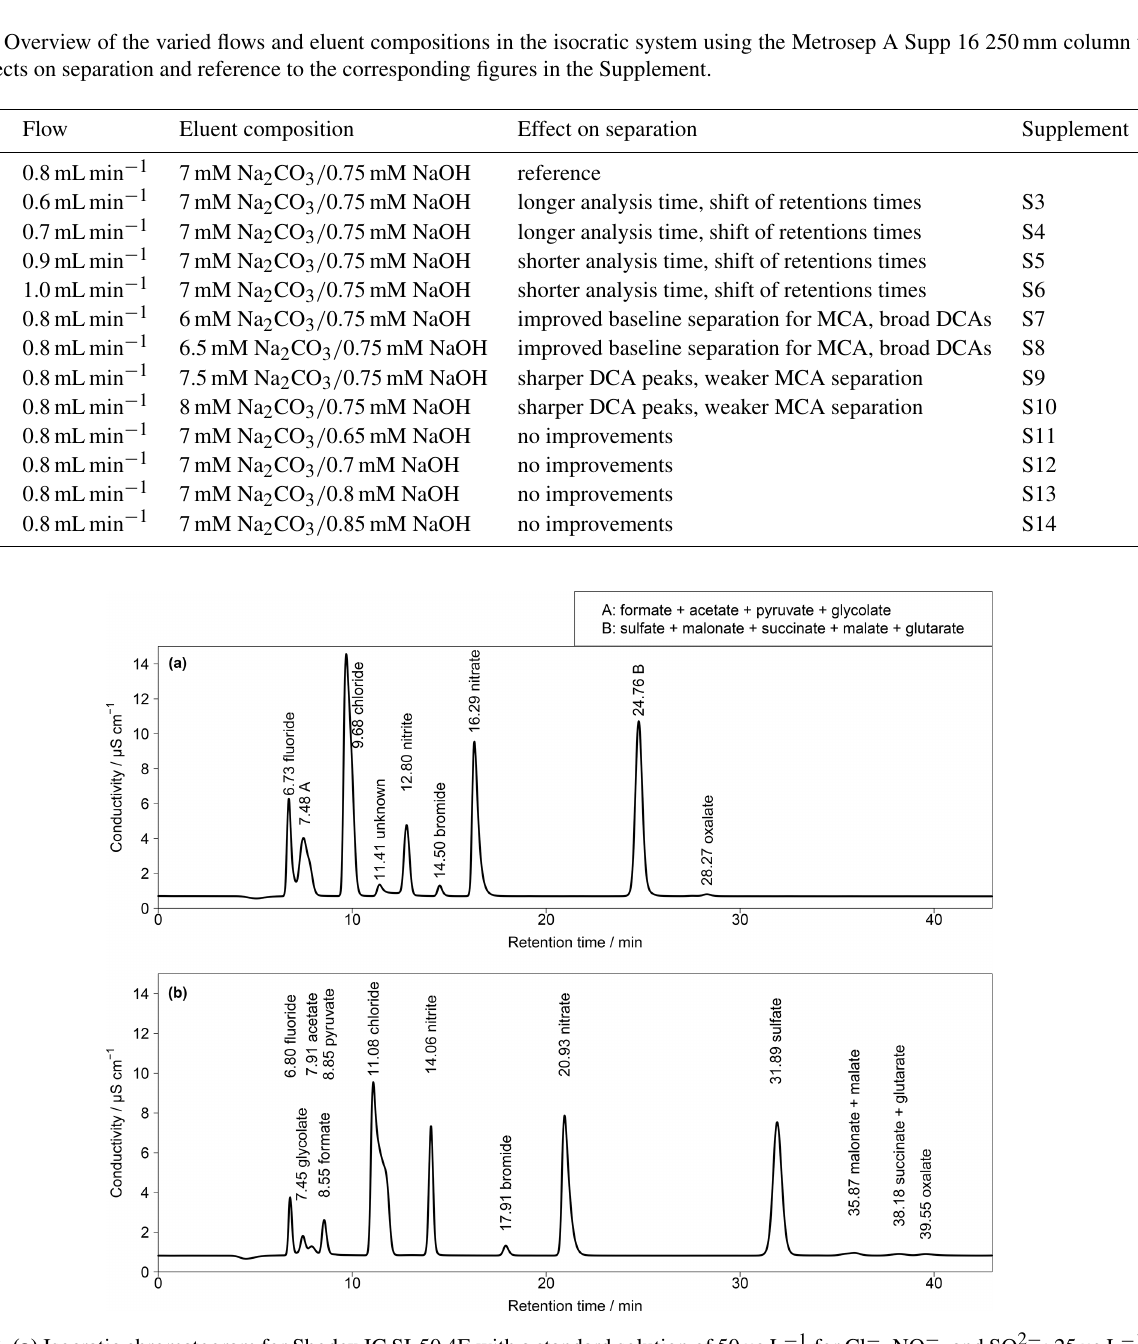
, and SO 2 − ; 25µgL − 1 for NO − ; 5µgL − 1 for F − and Br − ; and 3 4 2